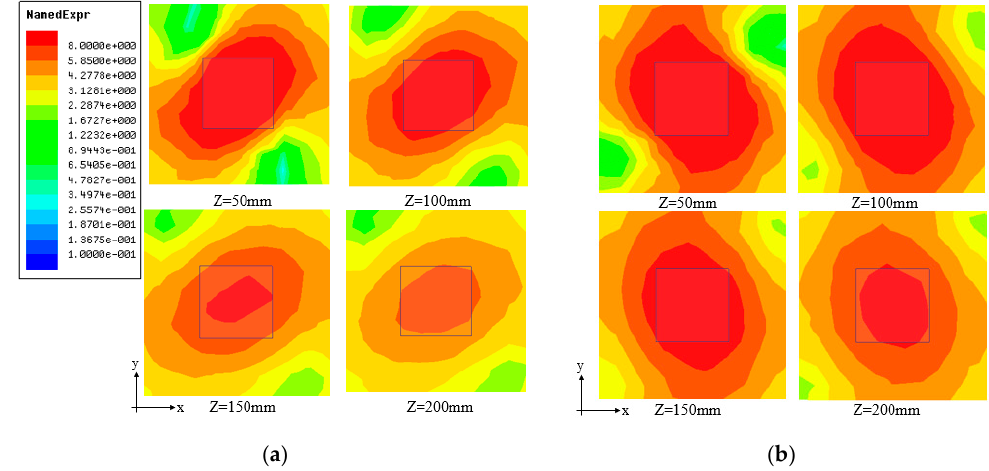
Figure 17. Distribution of simulated electric field components (Ex, Ey) at different heights when loop spacing d = 7 mm: ( a ) Ex distribution and ( b ) Ey distribution.